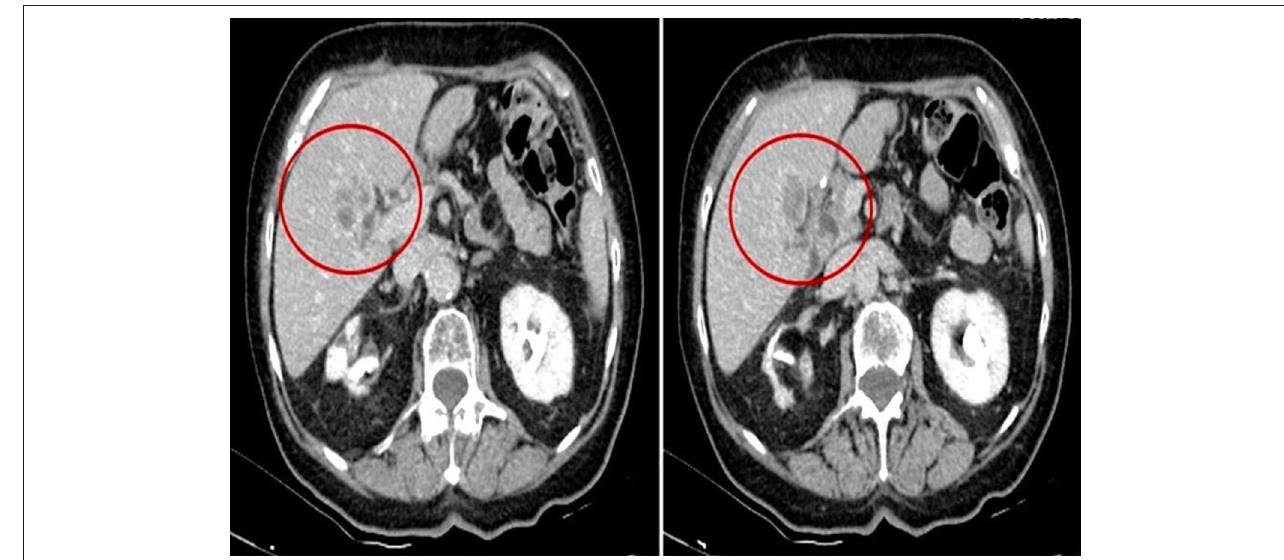
FIGURE 1 | Basal 28mm liver metastasis at IV segment in 2015/2016 (patient